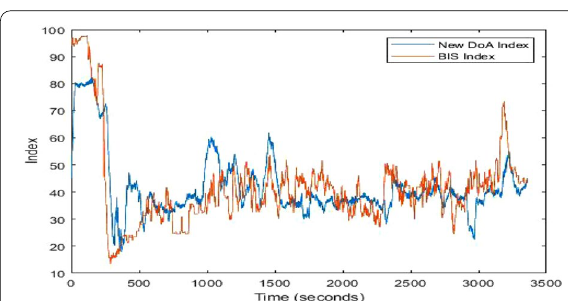
Fig. 8 The new DoA index (Patient ID 16, r